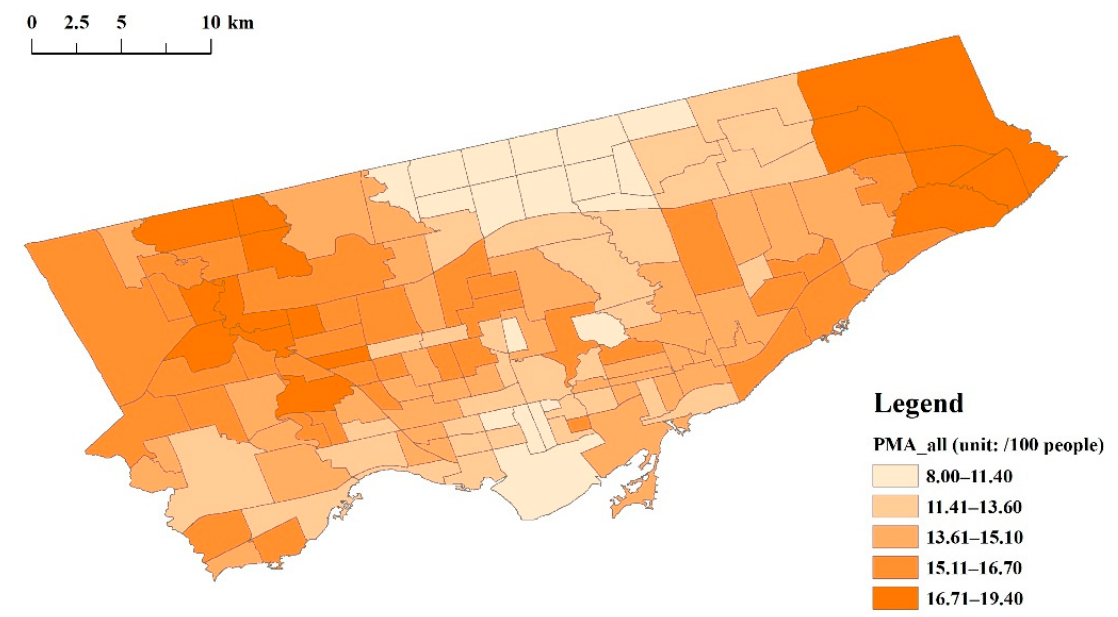
Figure A2. Distribution of the prevalence of male asthmatics at all ages (PMA_all).